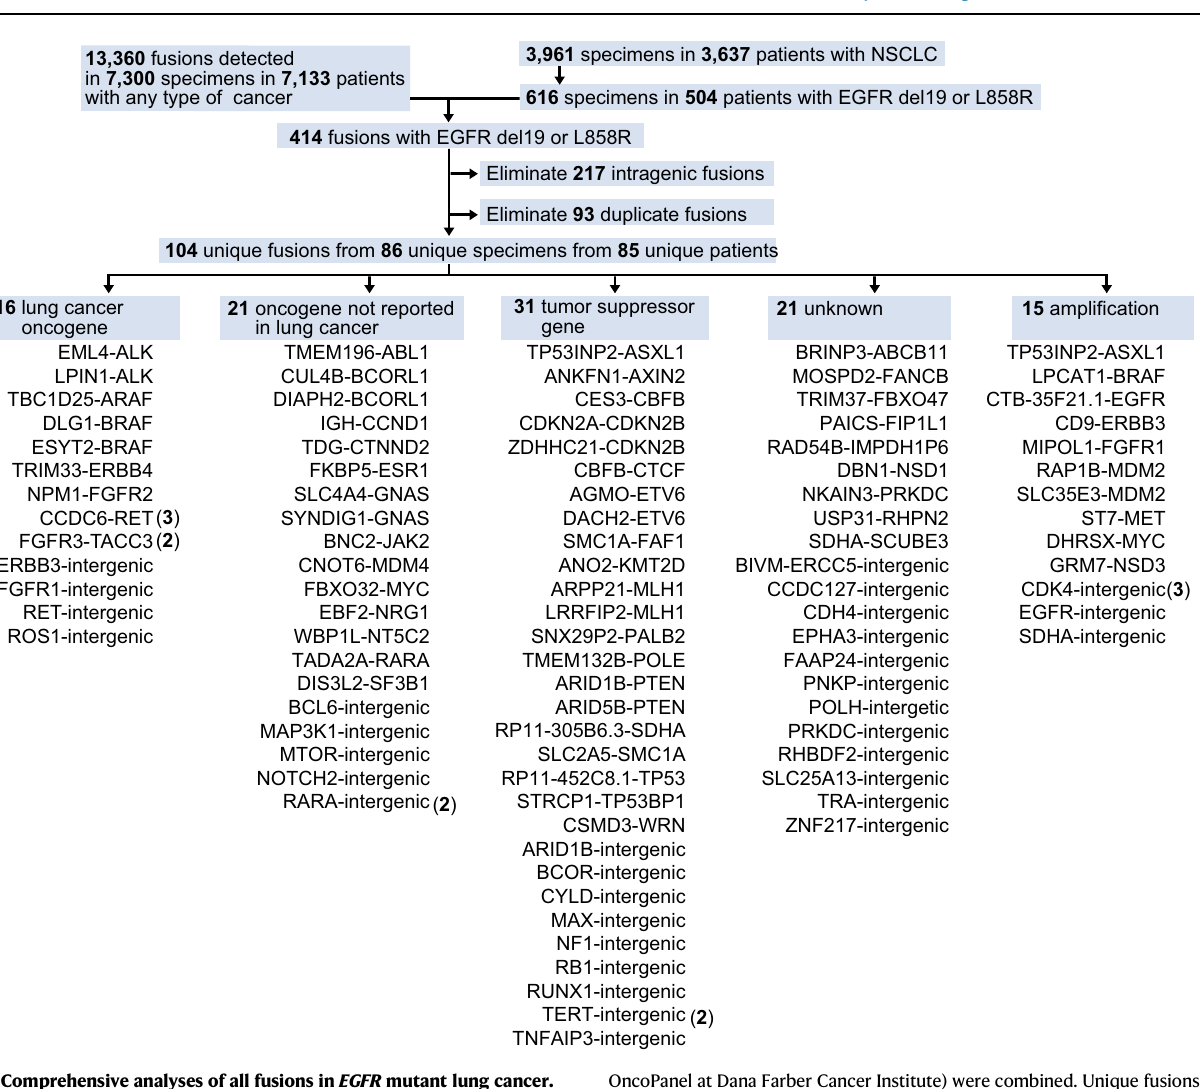
OncoPanel at Dana Farber Cancer Institute) were combined. Unique fusions iden- ti fi edinpatientswith EGFR L858Rordeletioninexon19(del19)wereclassi fi edinto fi ve